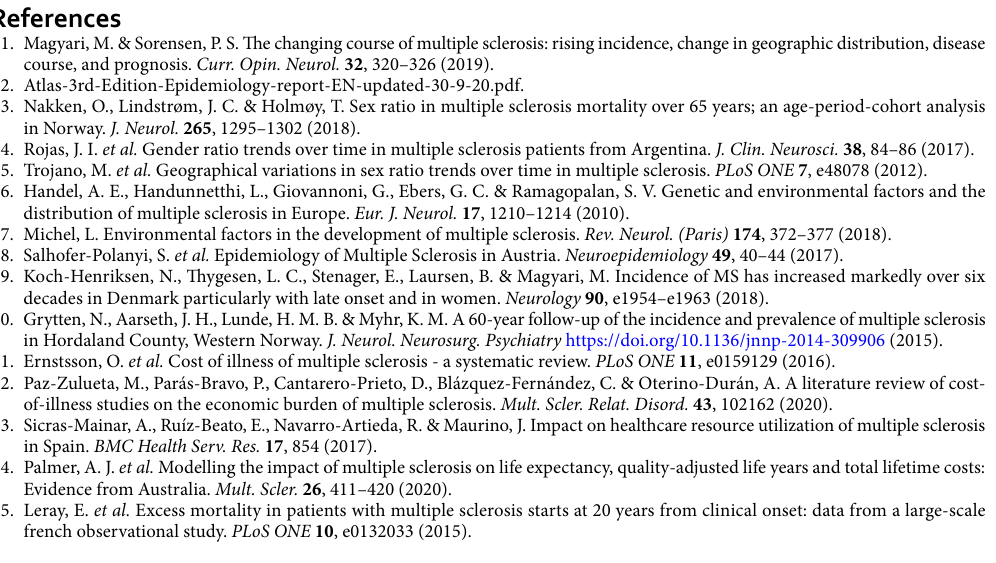
µ i, k = α i + β j + γ k + δ . The predictor μ i,k is constructed from time effects for age, α i ; period, β j ; and cohort, γ k and an error term, δ. However, these time effects cannot be fully recovered from the predictor because of the identification problem. In other words, knowledge of the predictor from the likelihood, which is a function of the predictor, is not enough to reveal the time effects. This identification problem can be circumvented by a parsimonious parametrization 50 . This parametrization allowed for the formulation of 14 nested sub-models within the age-period-cohort model (Fig. 5). The deviance of the sub-models is calculated against a chi-square distribution, its p-value and the Akaike Information Criteria (AIC) associated with the log-likelihood ratio statistics for the sub-models against the age-period-cohort model. Analyses were conducted with R 3.4.2. APC analyses were conducted with the apc package 2.0.0. All methods were carried out in accordance with relevant guidelines and regulations. Ethics approval. The data are extracted from a population-based register certified by the French registry authorities in 2009 and approved by the French National Commission for Data Protection and Liberties (CNIL).